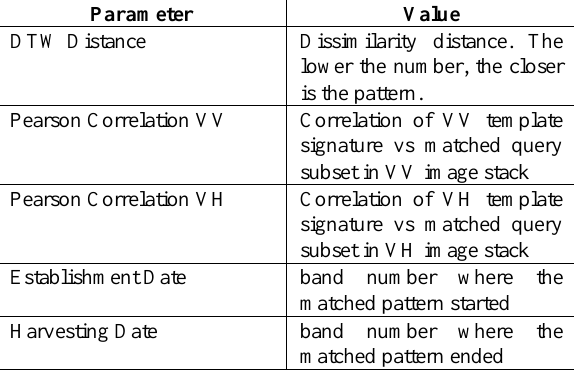
Table 3. Information found on the processed data.